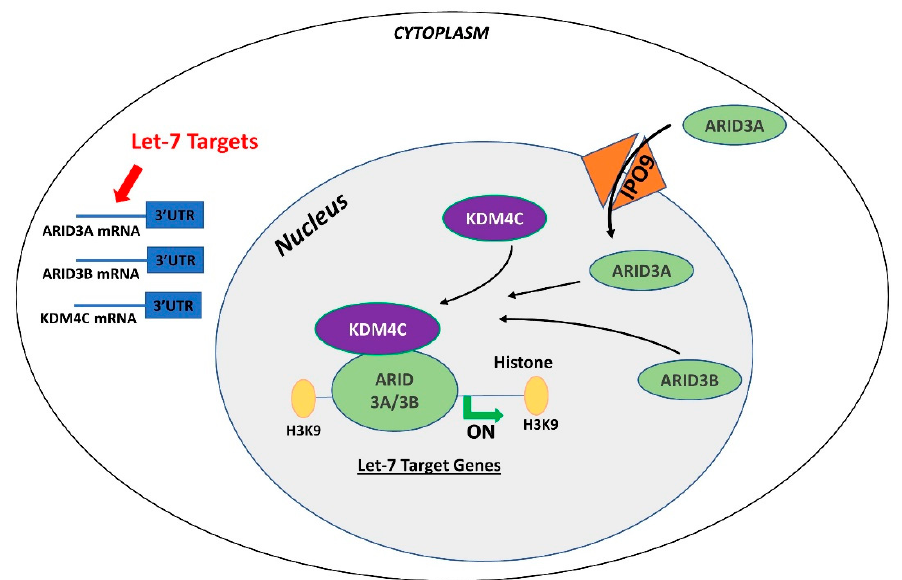
Figure 4. Gene regulation by the AT-rich interactive domain (ARID)3B complex. ARID3A is imported in the nucleus by importin 9 (IPO9), where it binds ARID3B and histone demethylase 4C (KDM4C) to form the ARID3B complex. The ARID3B complex binds in the promoter regions and activates transcription of let-7 target genes. Other than directly binding the mRNA of their target genes, let-7 miRNAs also target the ARID3B complex and reduce its expression, ultimately leading to reduced expression of let-7 target genes.